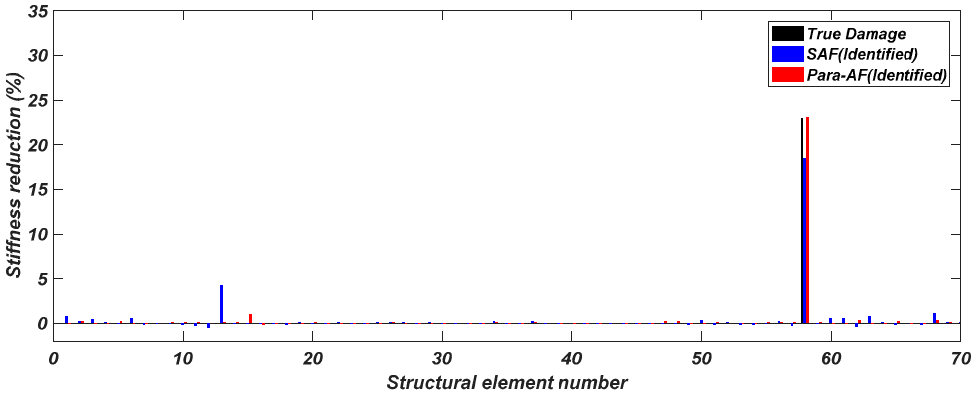
Figure 5. Damage identification results of a single damage case from SAF and the proposed approach.